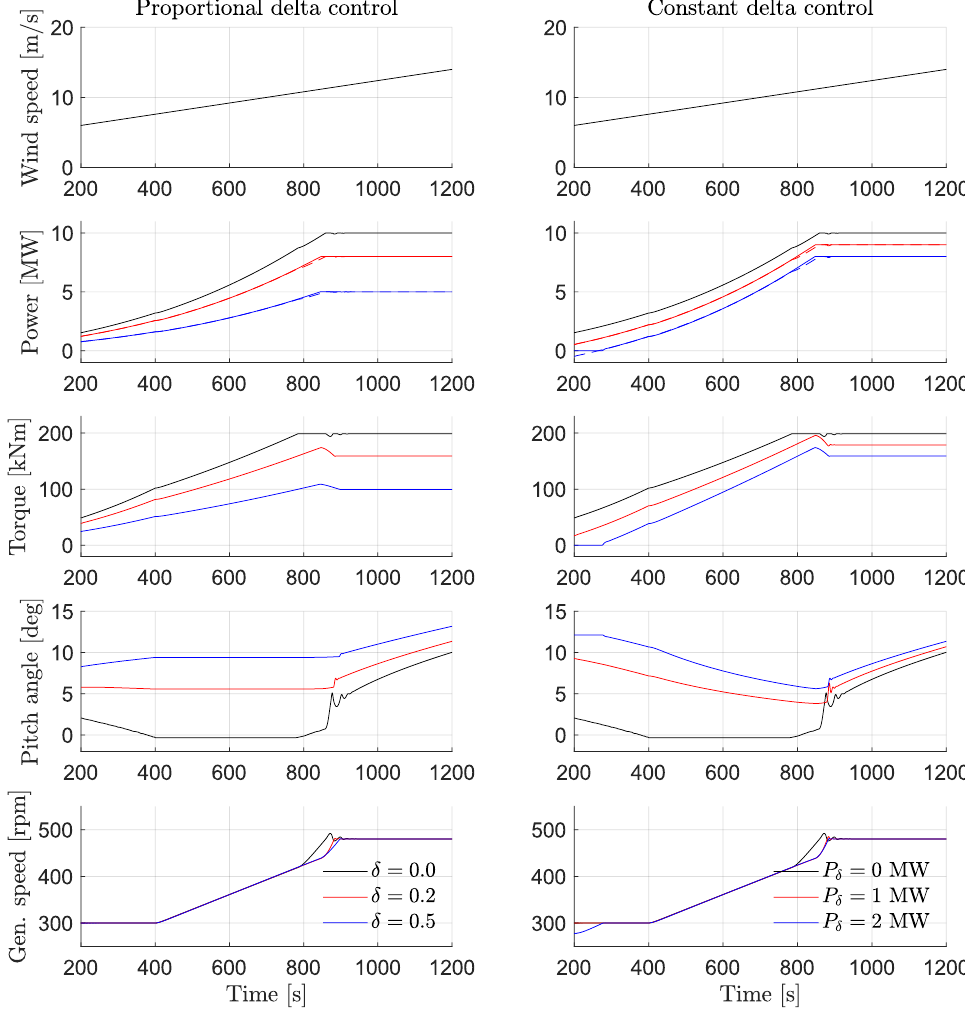
Figure 20. DTU 10-MW reference turbine with proportional and constant delta control, wind speed